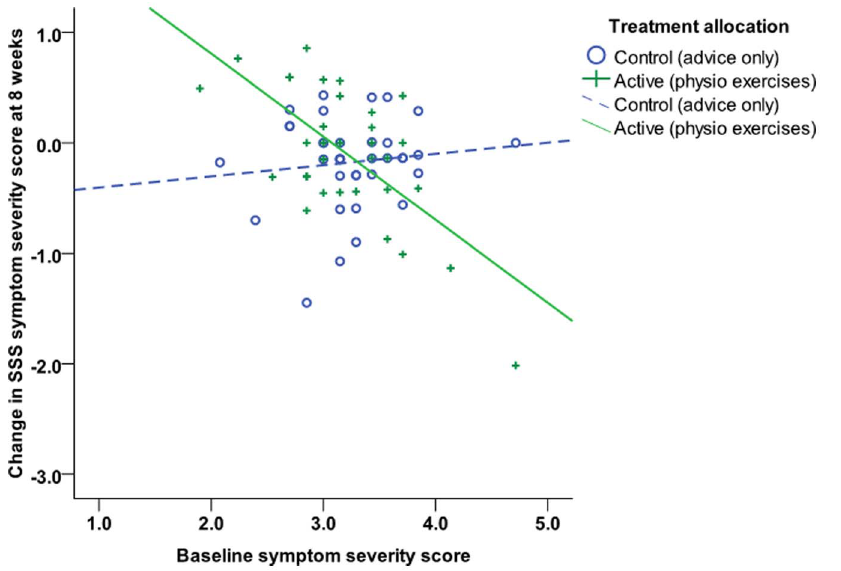
Figure 2. Change in SSS symptom severity score at eight weeks plotted against baseline values in the control group (circles; dotted line) and treatment group (crosses; solid line).